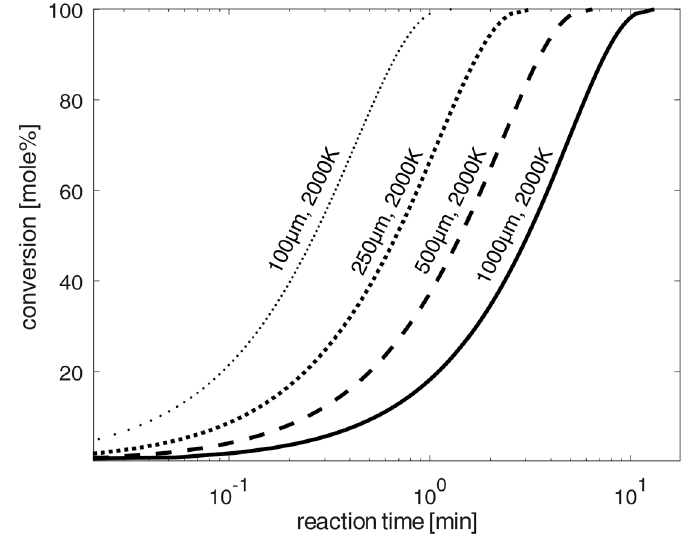
Figure 5. Schemes follow the same formatting. Estimation of the progress of chlorination of spherical oxidized NdFeB-magnet material particles at 2000 K according to the shrinking-core model [20] and the kinetic data from [4,24,26–28], and diffusion according to [22] for diffusion in air. Uncertainties of calculated values are mainly caused by uncertainties of kinetic constants and activation energies given in the literature. The variation in these parameters results in the average uncertainty of 15%.